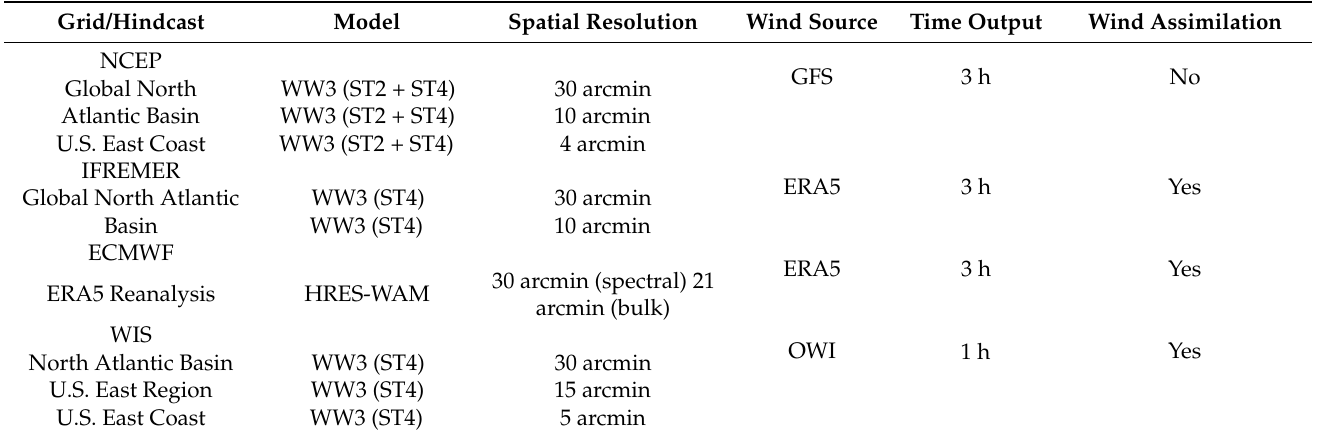
Table 2. Summary of numerical wave model setups used for this